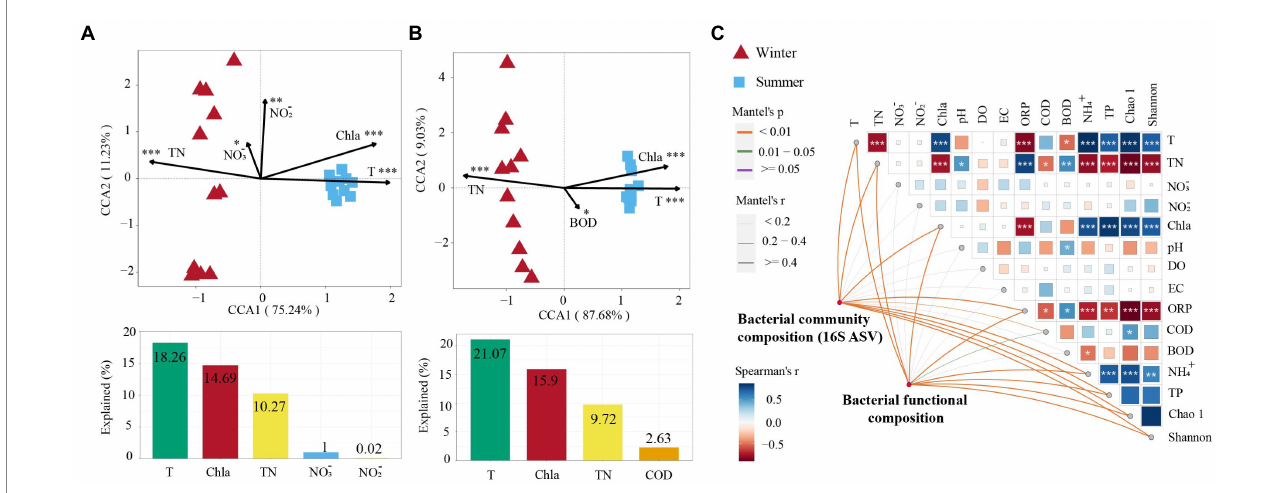
FIGURE 4 Drivers of bacterial community composition and bacterial function composition in subsidence lake and natural river. Canonical correspondence analysis (CCA) between (A) bacterial community composition and (B) function with significant environmental factors. Bar plots are shown below CCA presenting the variation explained by each factor. (C) The correlation of bacterial community composition, environmental factors, and bacterial functional composition using the Mantle test. * p < 0.05, ** p < 0.01, *** p < 0.001.